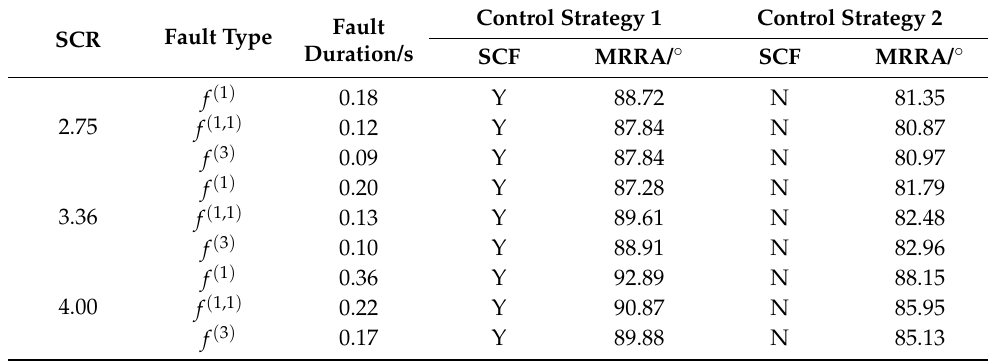
Table 2. Comparison of simulation results by different control strategies at different SCRs.